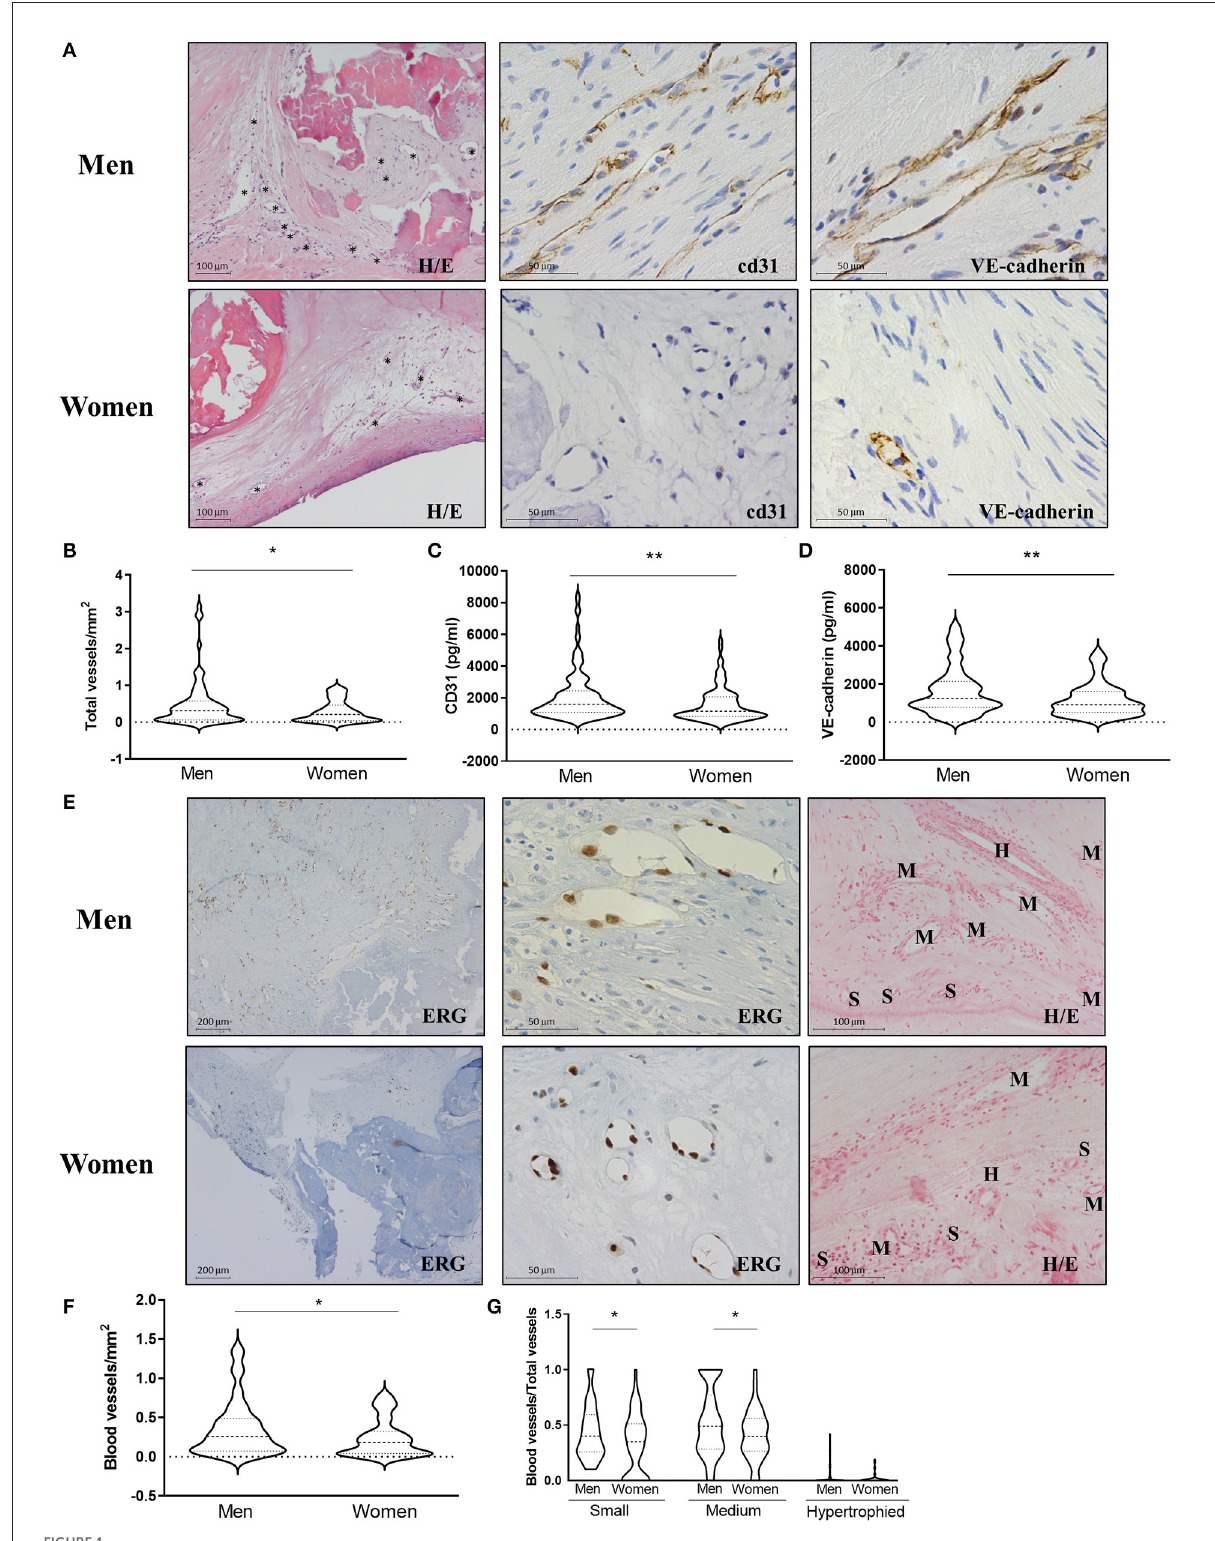
FIGURE1 Sex differences in neovessels density in AVs from AS patients. Representative microphotographs of AV sections from men and women AS patients stained for hematoxylin/eosin and immunostained for CD31 and VE-cadherin AV tissue (A) . Asterisk indicates neovessels. Total vessel density